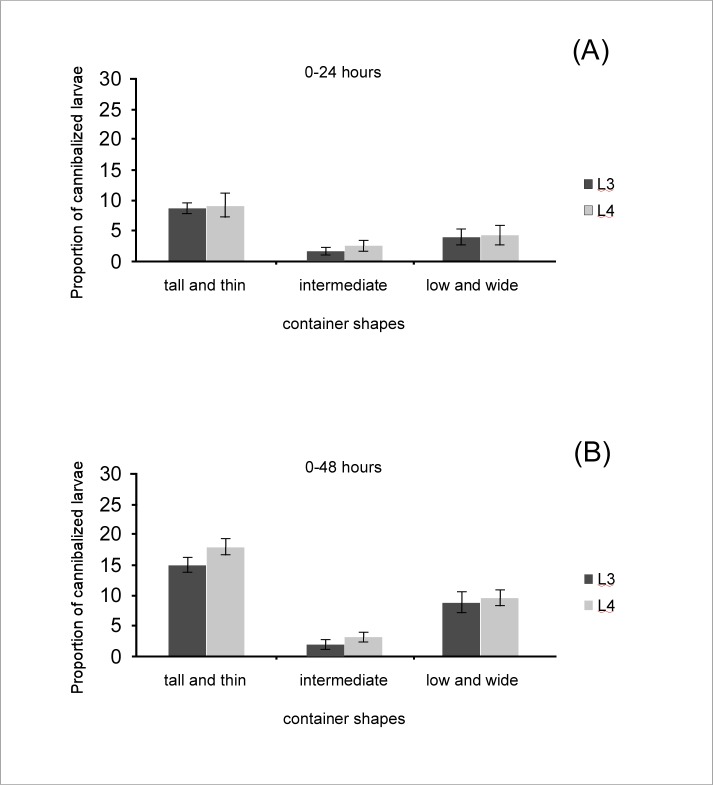
Cannibalism rate between Aedes albopictus larvae.The proportion of the cannibalized first-instar larvae is shown for each container shape. The values are shown as mean ± standard deviations. L3: third-instar larvae; L4: fourth-instar larvae.